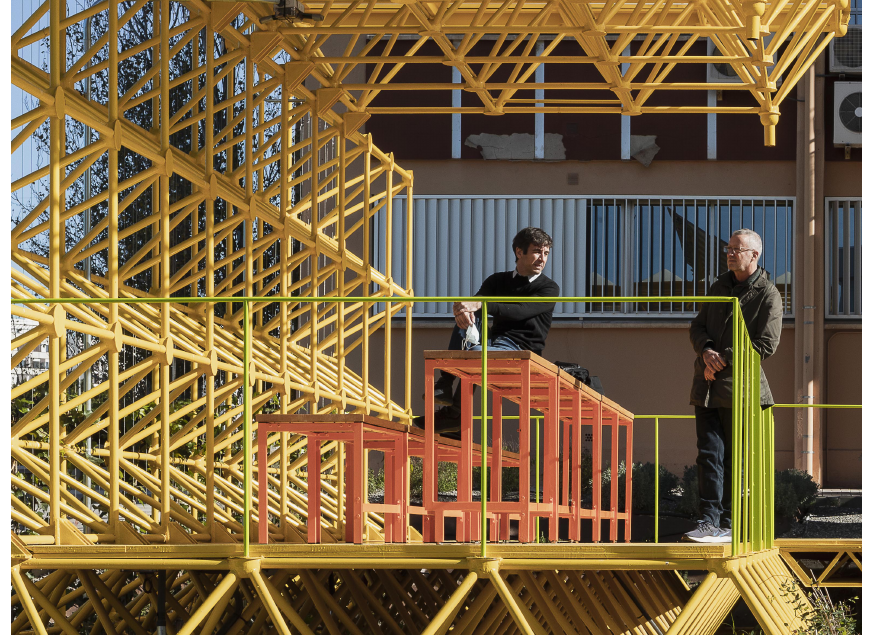
Figure 8. Smart Tree